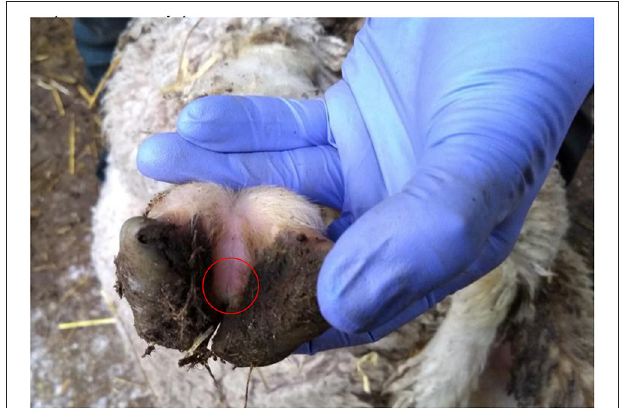
FIGURE 2 | Photograph of a mild interdigital lesion (whitish skin in the circle) from flock K where no sheep were lame and only aprB2 variant of D. nodosus was